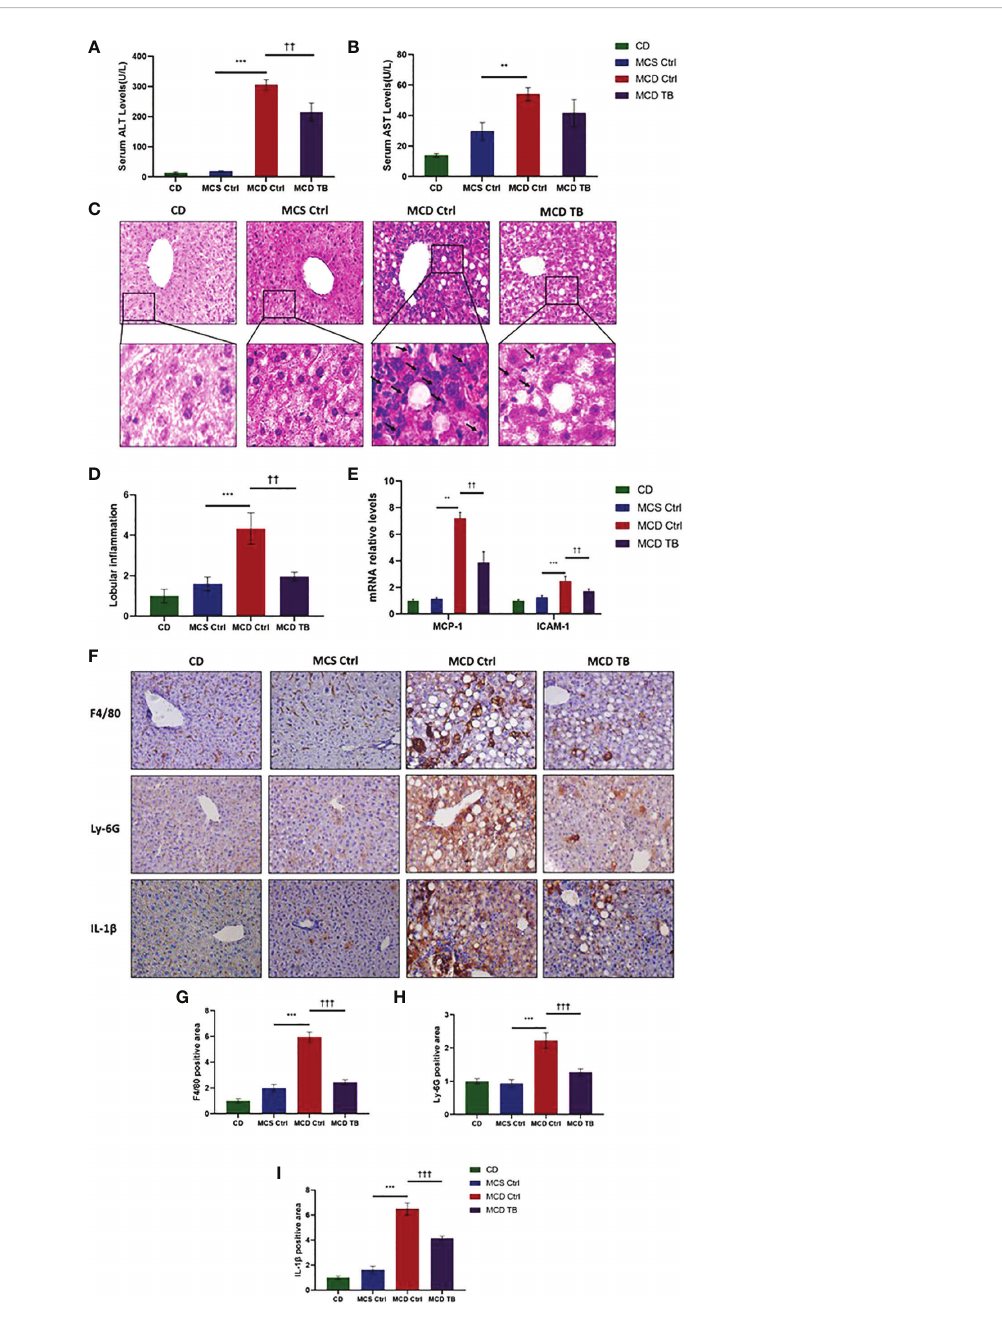
FIGURE 2 Theabrownin improves liver injury and in fl ammation in MCD diet-fed mice. (A) Serum ALT level. (B) Serum AST level. (C) Liver section for H&E staining. (D) Quanti fi cation of lobular in fl ammation. (E) mRNA levels for MCP-1 and ICAM-1. (F) Liver section for IHC with F4/80, Ly-6G, and IL-1 b . (G – I) Quanti fi cation of positive area for F4/80, Ly-6G, and IL-1 b . n=5-11 mice per group. The data are mean ± s.e. (error bars). **p < 0.01, ***p < 0.001, MCS Ctrl vs. MCD Ctrl; †† , p<0.01, ††† , p<0.001 MCD Ctrl vs. MCD